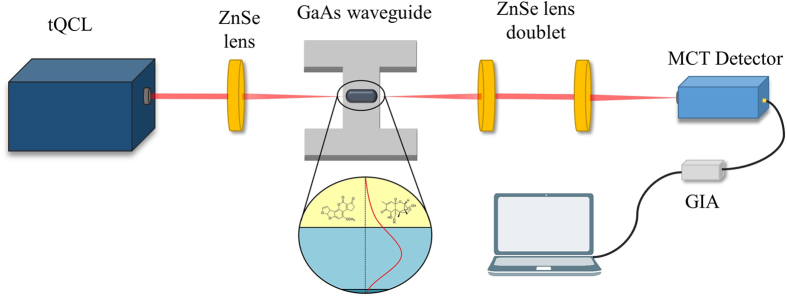
Schematic of the MYCOSPEC sensor system comprising a tunable quantum cascade laser, ZnSe lenses, a GaAs/AlGaAs thin-film waveguide slab, and a TE-cooled MCT detector.